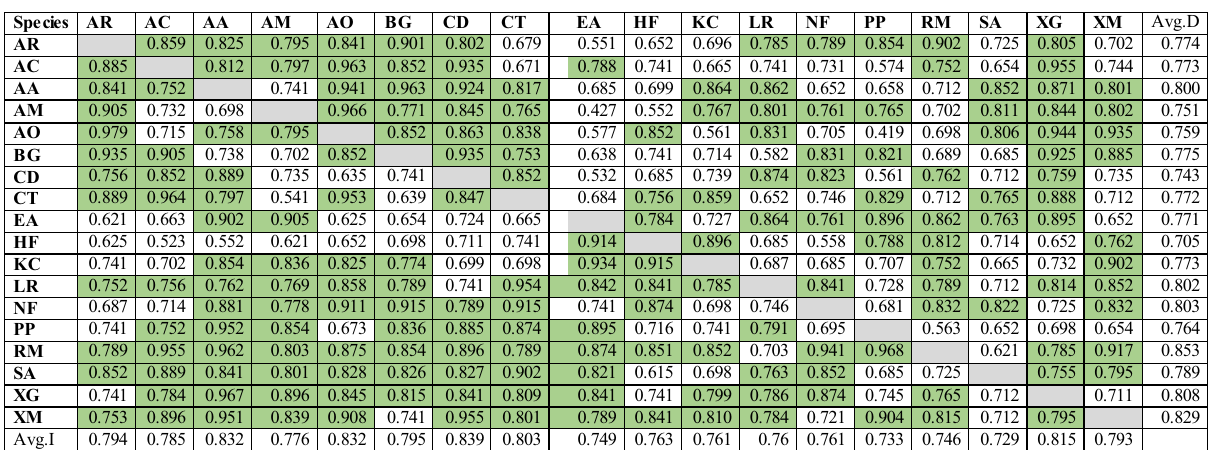
Table 5. Estimates of niche overlap between selected species: upper diagonals: Schoener’s index of niche breadth (D); lower diagonals: modified Hellinger metric (I). The green colour indicate significance at p < 0.05